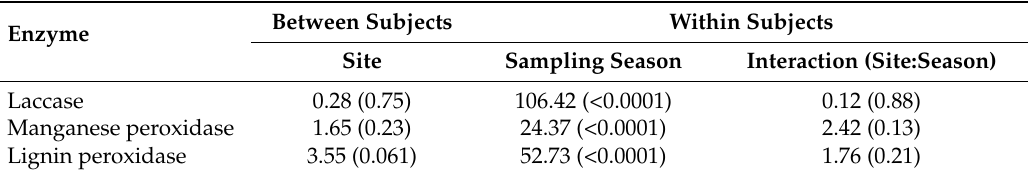
Table 2. F ( p ) values from the RMANOVAs of enzymatic activity in Quercus deserticola litter in three forest sites with increasing levels of disturbance in central Mexico.